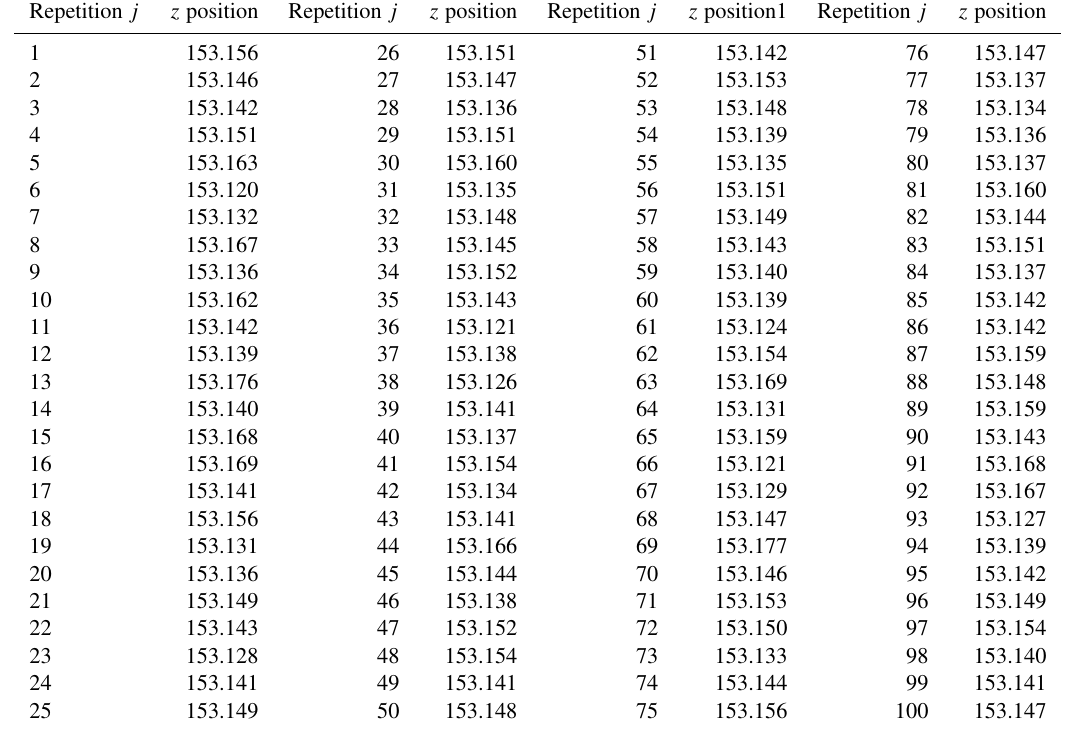
Table A1. Reconstructed object positions along the z axis of 100 holograms without moving the